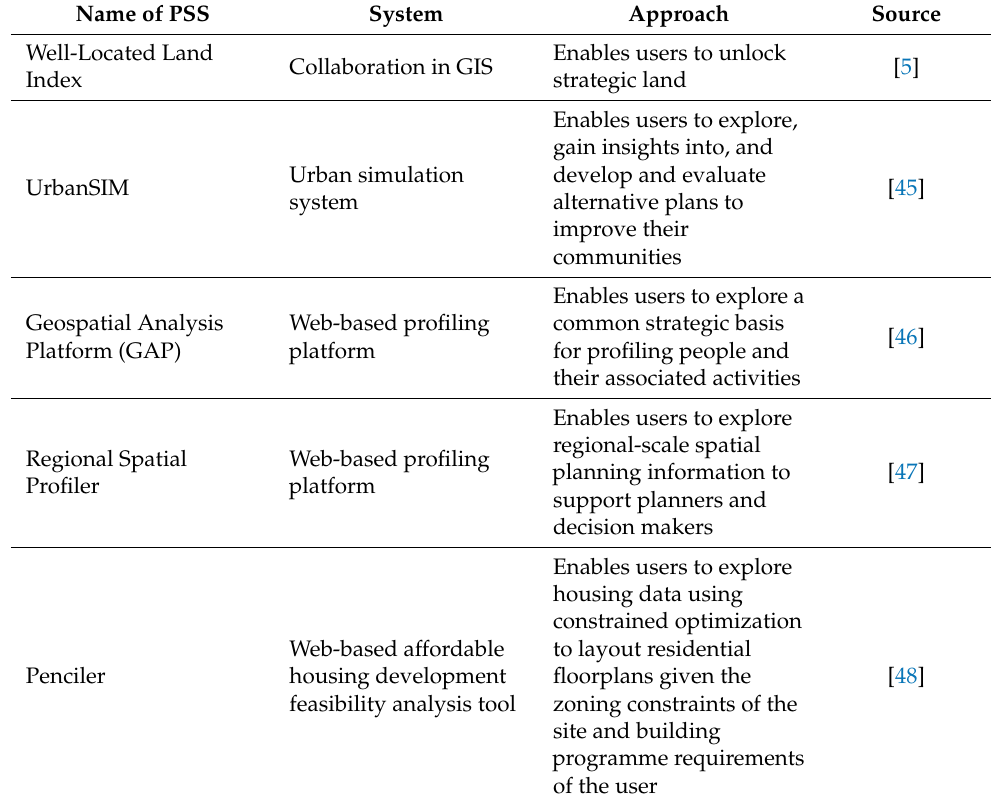
Table 1. List of PSSs in Southern